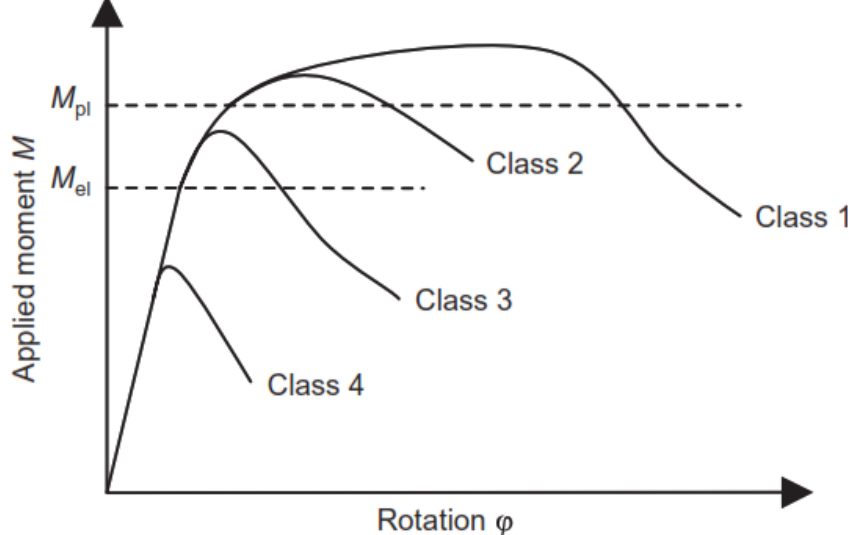
Figure 1. Moment–rotation responses of four cross-sectional behavioral